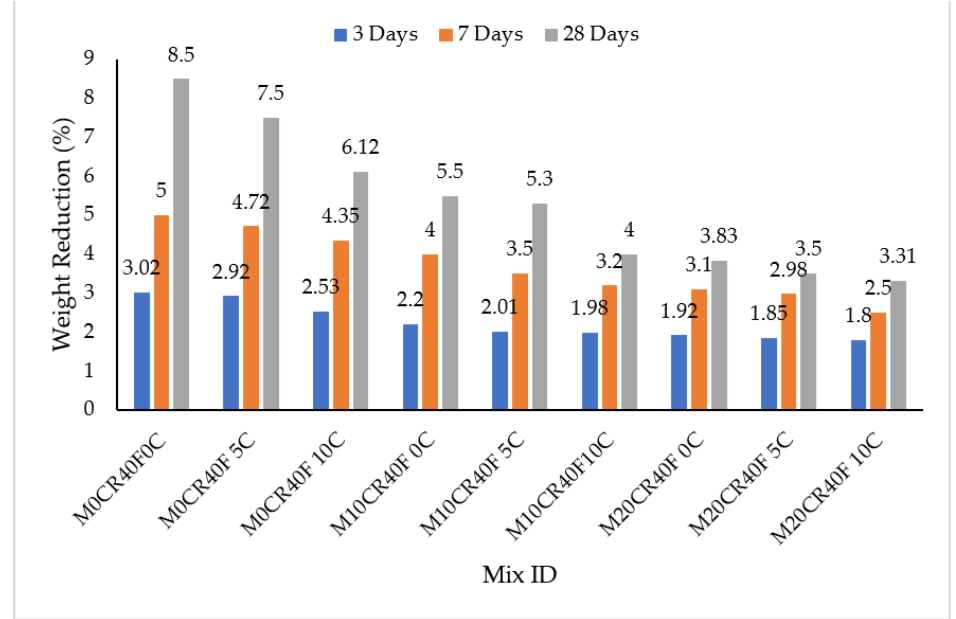
Figure 3. Immersion periods in H 2 SO 4 for SCC mixes containing fly ash, CR, and